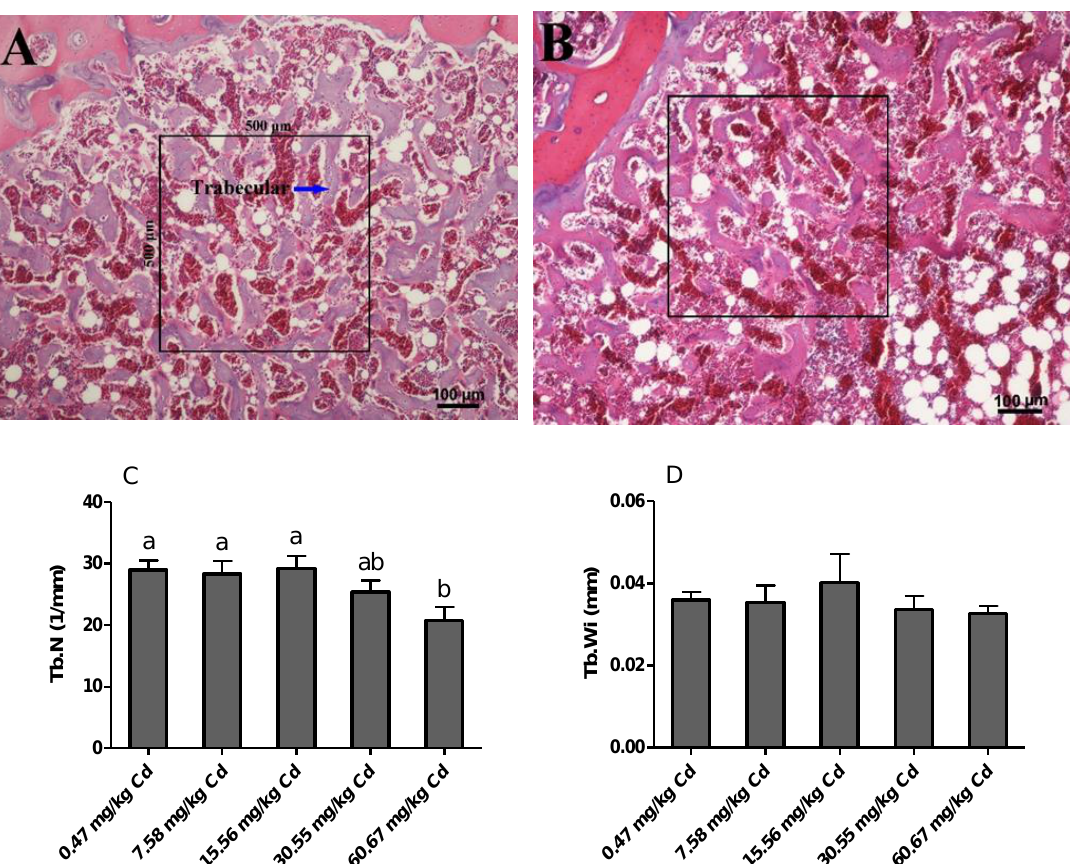
Figure 4. Photomicrographs of hematoxylin and eosin (H & E) stained (100 × magnification, bar = 100 μm, n = 6) longitudinal sections of the tibia showing the decrease in bone volume observed in Cd (60.67 mg/kg group) exposed animals ( B ) as compared to controls (0.47 mg/kg Cd group) ( A ). ( C ) trabecular number; ( D ) trabecular width. Values are presented as the mean ± SE ( n = 6). a–b Means with different superscript letters are significantly different ( p < 0.05).